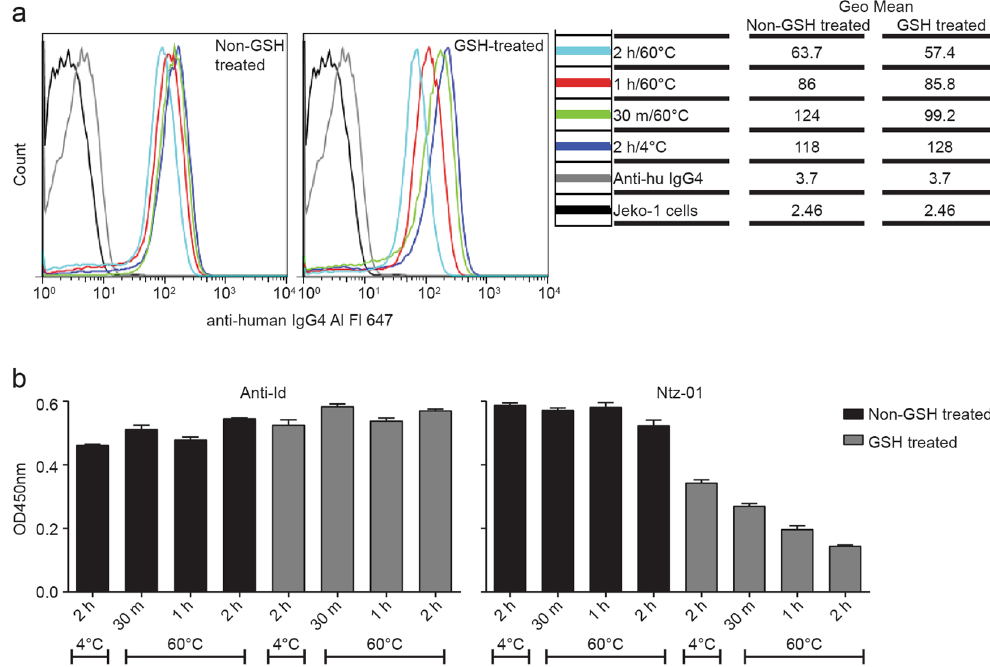
Figure 3. Binding stability of heat exposed natalizumab ( a ) Functional binding of heat exposed natalizumab samples to CD49 + JeKo-1 cells. Both GSH treated and non-GSH treated natalizumab samples were tested. ( b ) Binding of heat exposed natalizumab samples in peptide (Ntz-01) ELISA and anti-Id ELISA. For ( b ) one representative experiment is shown, with error bars representing SD of duplicate